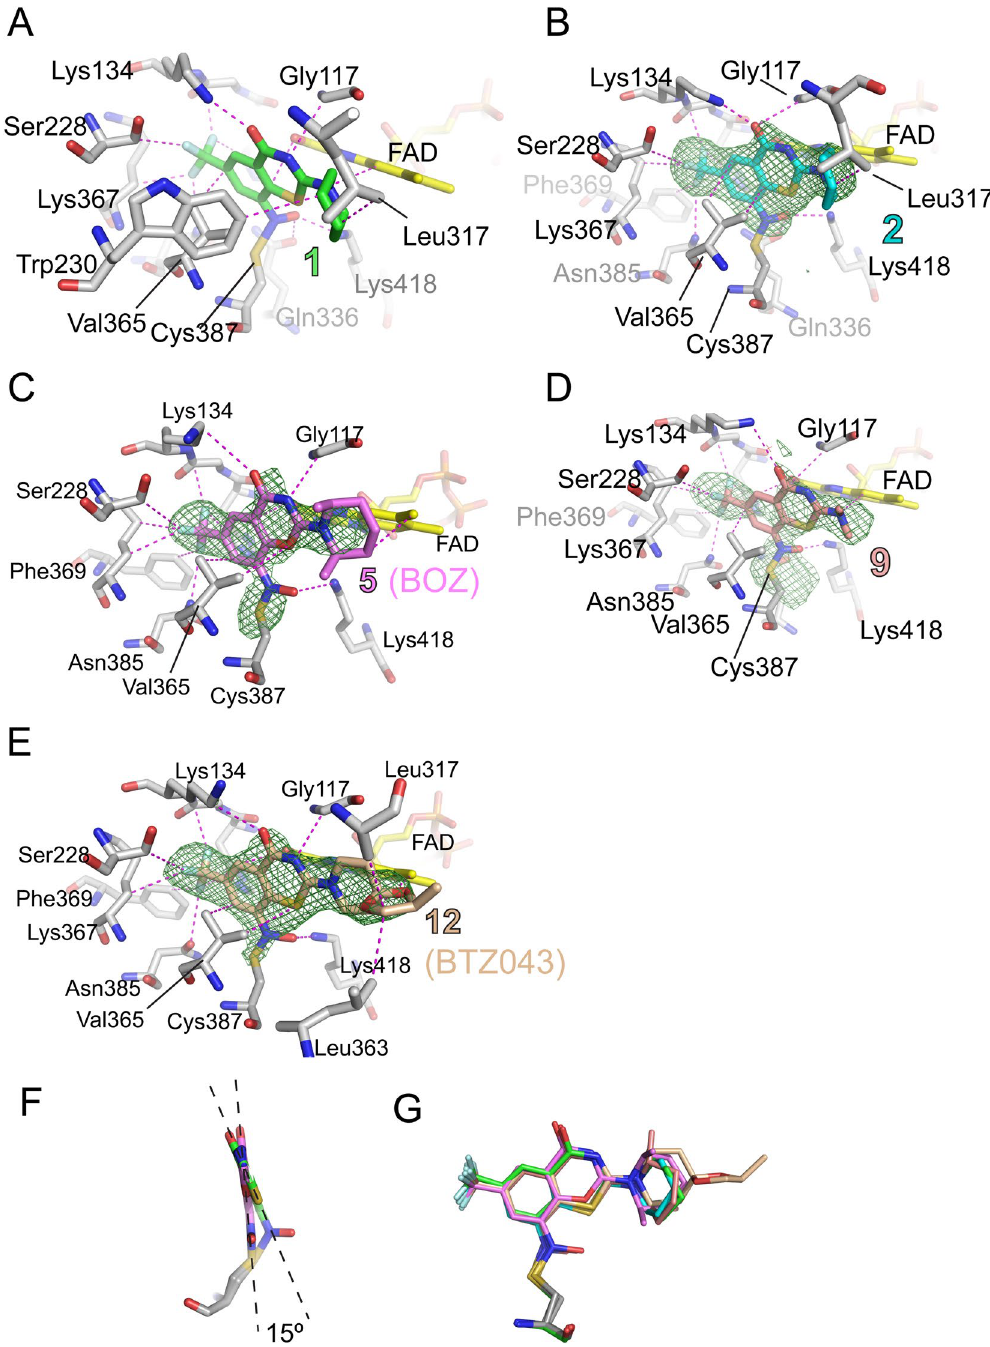
Figure 5. Contacts of BTZ and BOZ compounds with DprE1 and variation of inhibitor orientation. ( A – E ) Views of contacts (dashed lines in magenta) between BTZ, BOZ compounds with the active site of Mtb-DprE1. In ( A ), a 4 Å-distance cut-off was applied. Carbon atoms are colored in light grey (protein), yellow (FAD) and according to inhibitor identity. The unbiased Fo-Fc density (contour level 3 σ ) in panels B–E was calculated with model phases prior to incorporating the inhibitor in the coordinate set. In panel C, Trp230 was omitted for clarity. ( A ) Compound 1 (PDB entry 6HFW). ( B ) Compound 2 (PDB 6HFV). ( C ) Compound 5 (PDB 6HF0). ( D ) Compound 9 (PDB 6HF3). ( E ) Compound 12 (PDB 6HEZ, BTZ043). ( F ) Comparison of the orientation of the molecular planes of compounds 1 and 5. ( G ) Superimposing compounds 1, 2, 5, 9 and 12 after aligning the proteins according to secondary structure matching. Stick models are colored as in panels